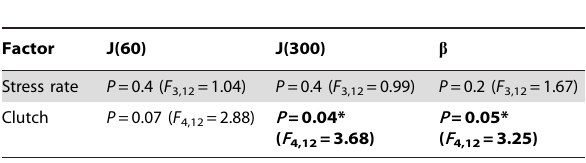
Table 1. ANOVA table. Stress application rate vs. viscoelastic